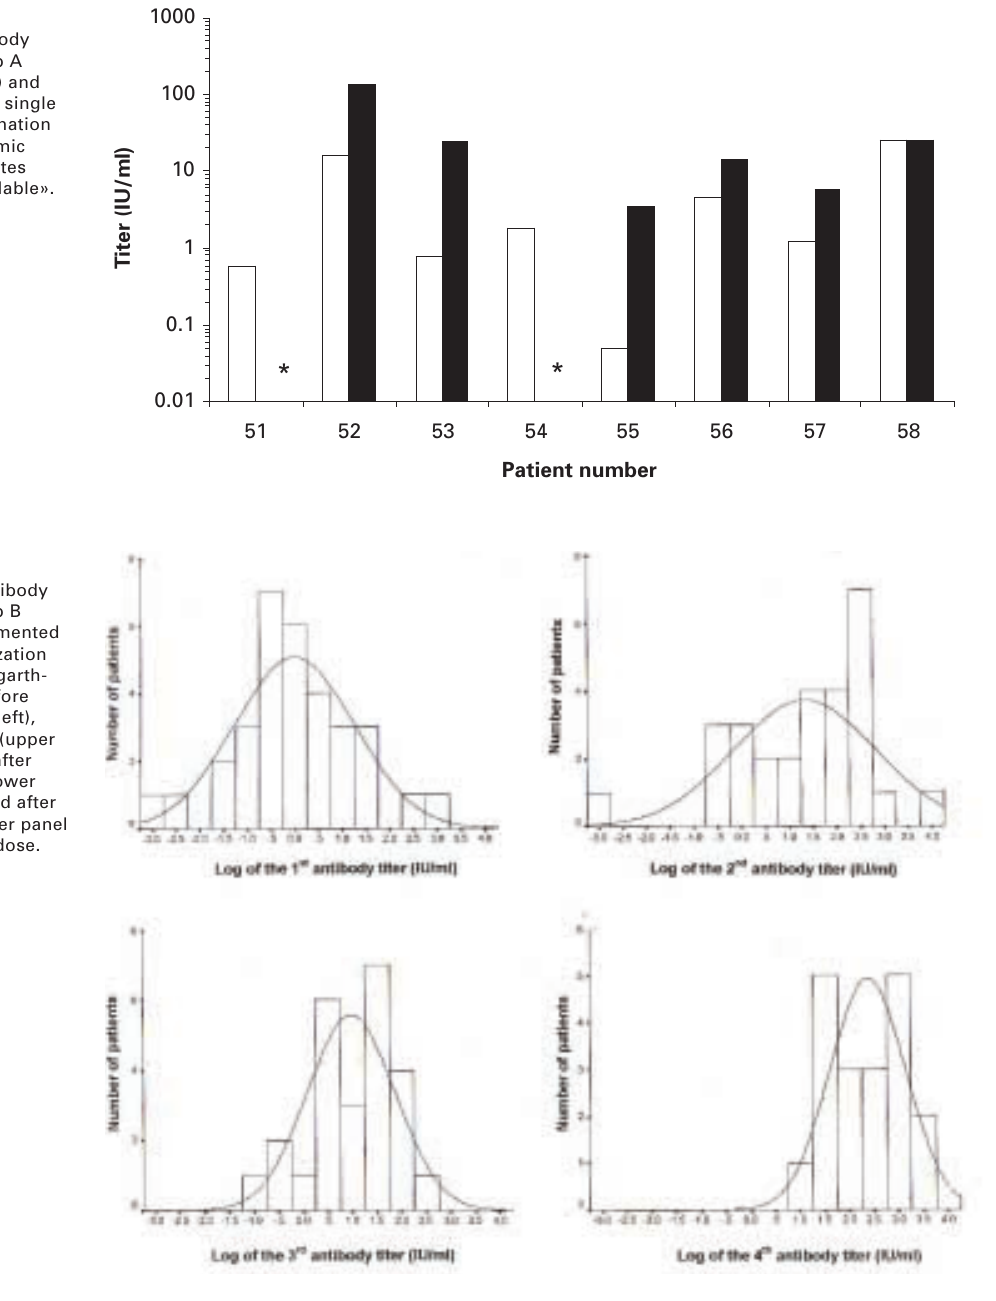
Figure 2 Tetanus antibody titres in group A before (white) and after (black) a single booster vaccination (half-logarithmic scale). * denotes «no data available».